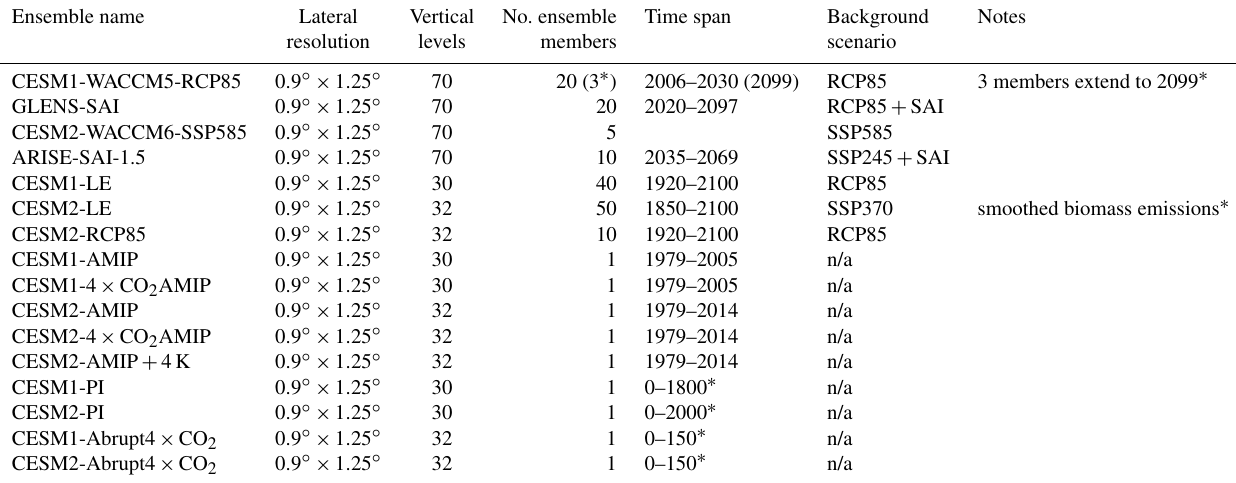
Table 1. Climate model experiments used in this study and their design characteristics. Time spans are arbitrary for idealized experiments, as denoted by ( ∗ ).